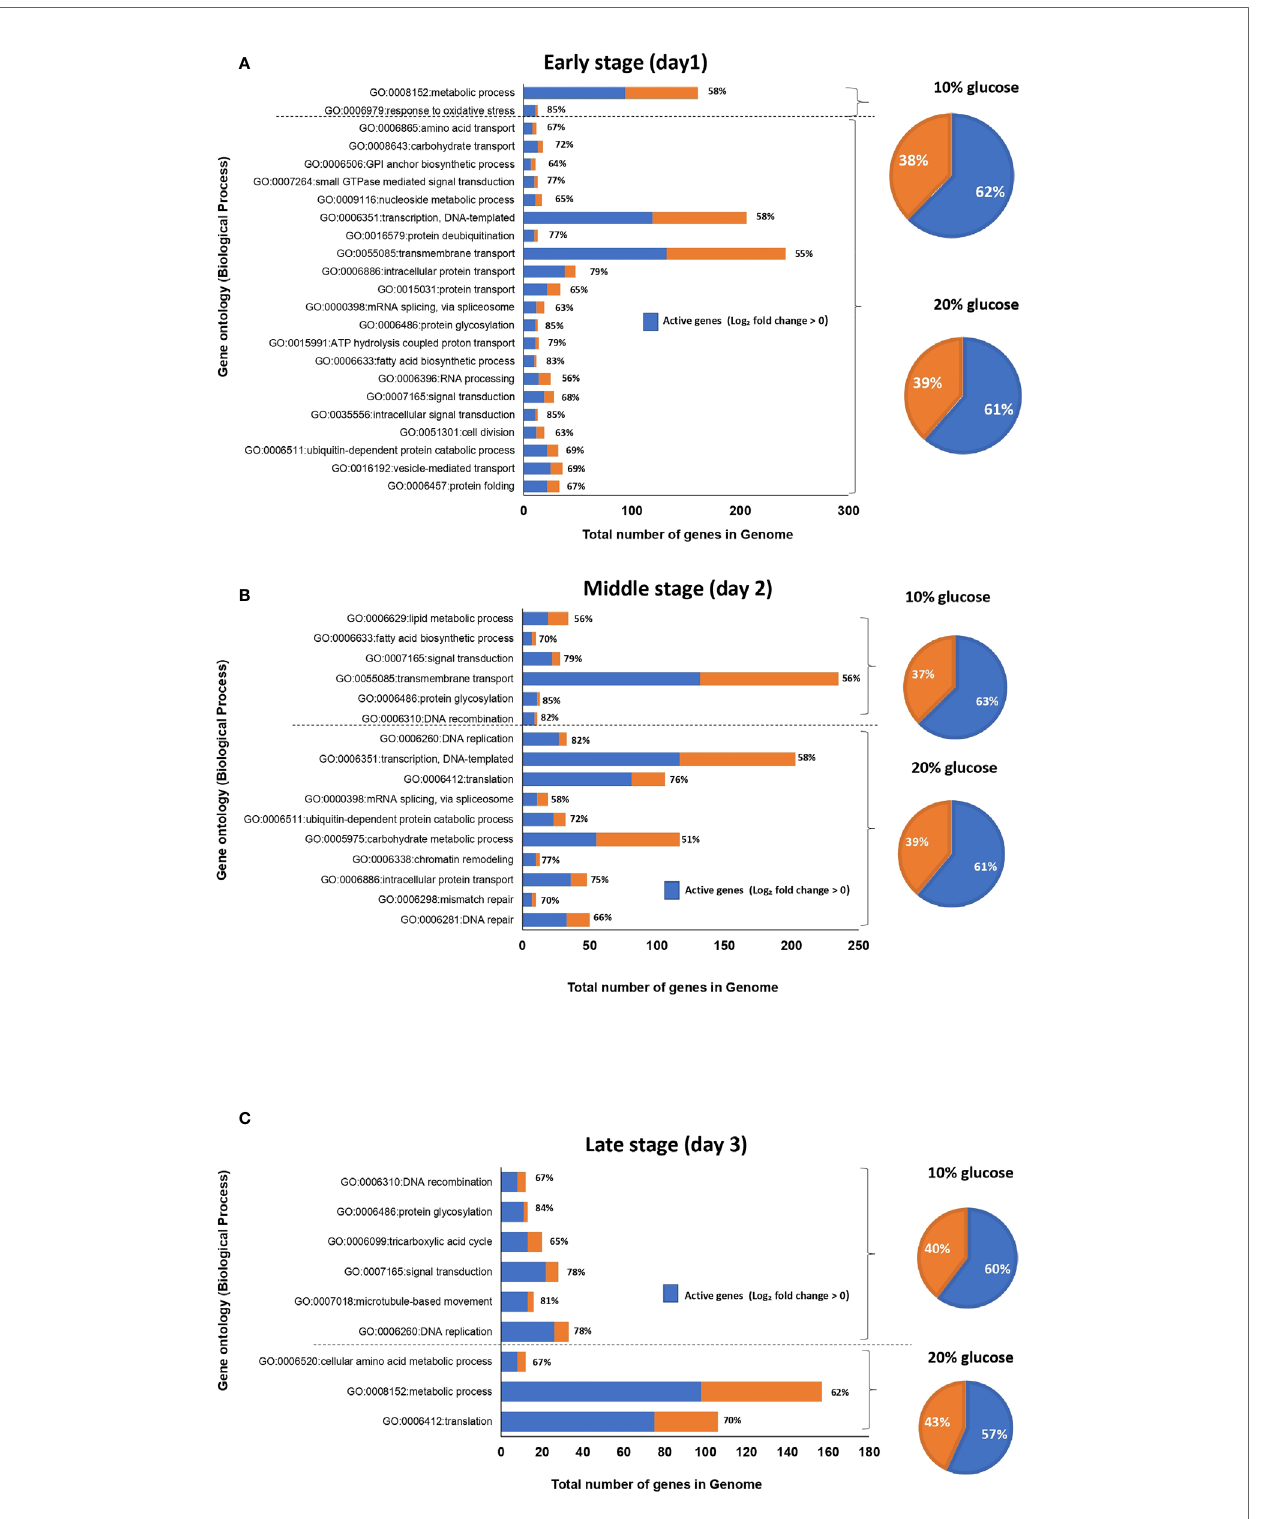
FIGURE 3 | Graphical representation of enriched gene ontology (GO) terms for the biological process of B. bassiana blastospores produced in liquid medium amended with 20% glucose compared to 10% glucose after one (A) , two (B) , and three (C) days of culture (FDR p < 0.25). The value in front of each bar represents the percentage of active genes (log2-FC > 0), in the set of genes associated with each GO-term. The pie chart illustrates the percentage of active genes (in blue) in 20% or 10% glucose treatment considering all enriched GO-terms for each day of fermentation (see also Supplemental Table S2